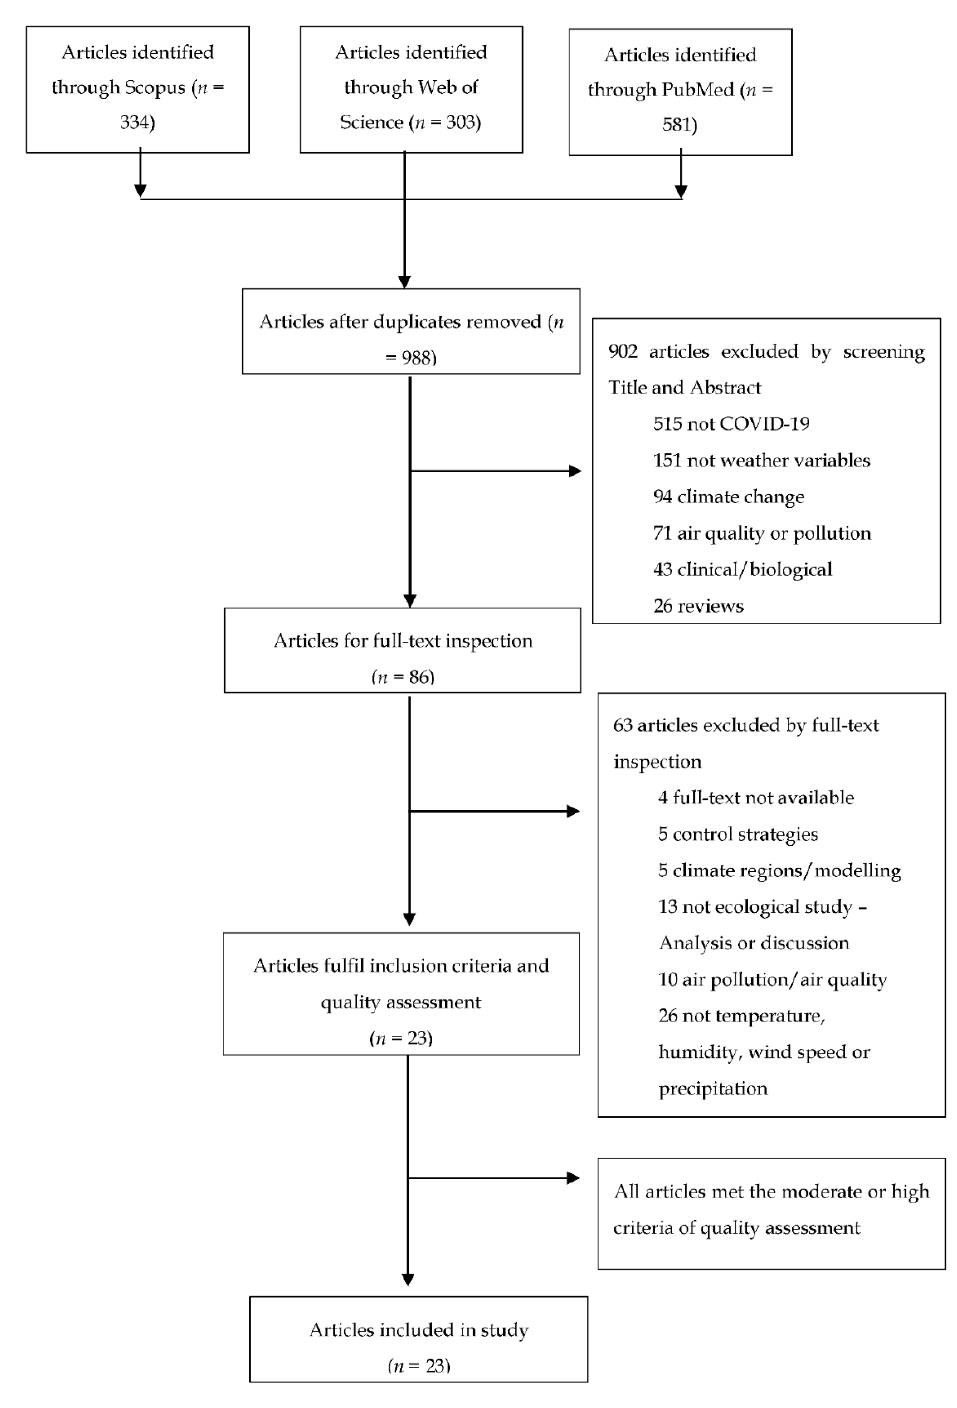
Figure 2. Study selection flow chart.